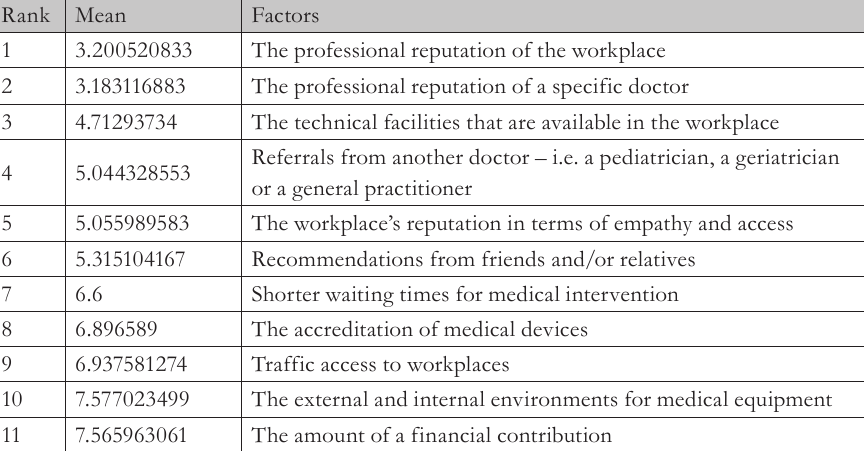
Tab. 8 – The rank and value of mean for the key factors influencing the decision-making proc- ess in the healthcare market (Source: own